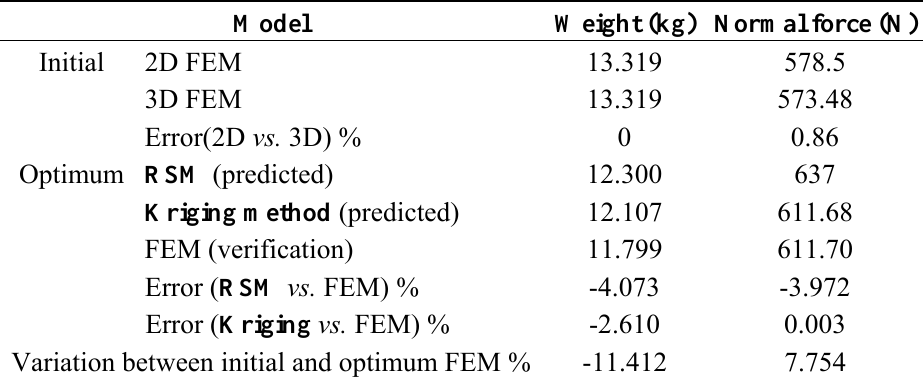
Table 5. Comparison of initial and optimum